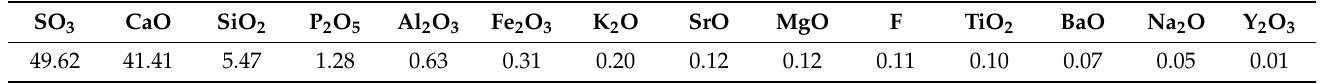
Table 1. Main chemical composition analysis of phosphogypsum (mass fraction,